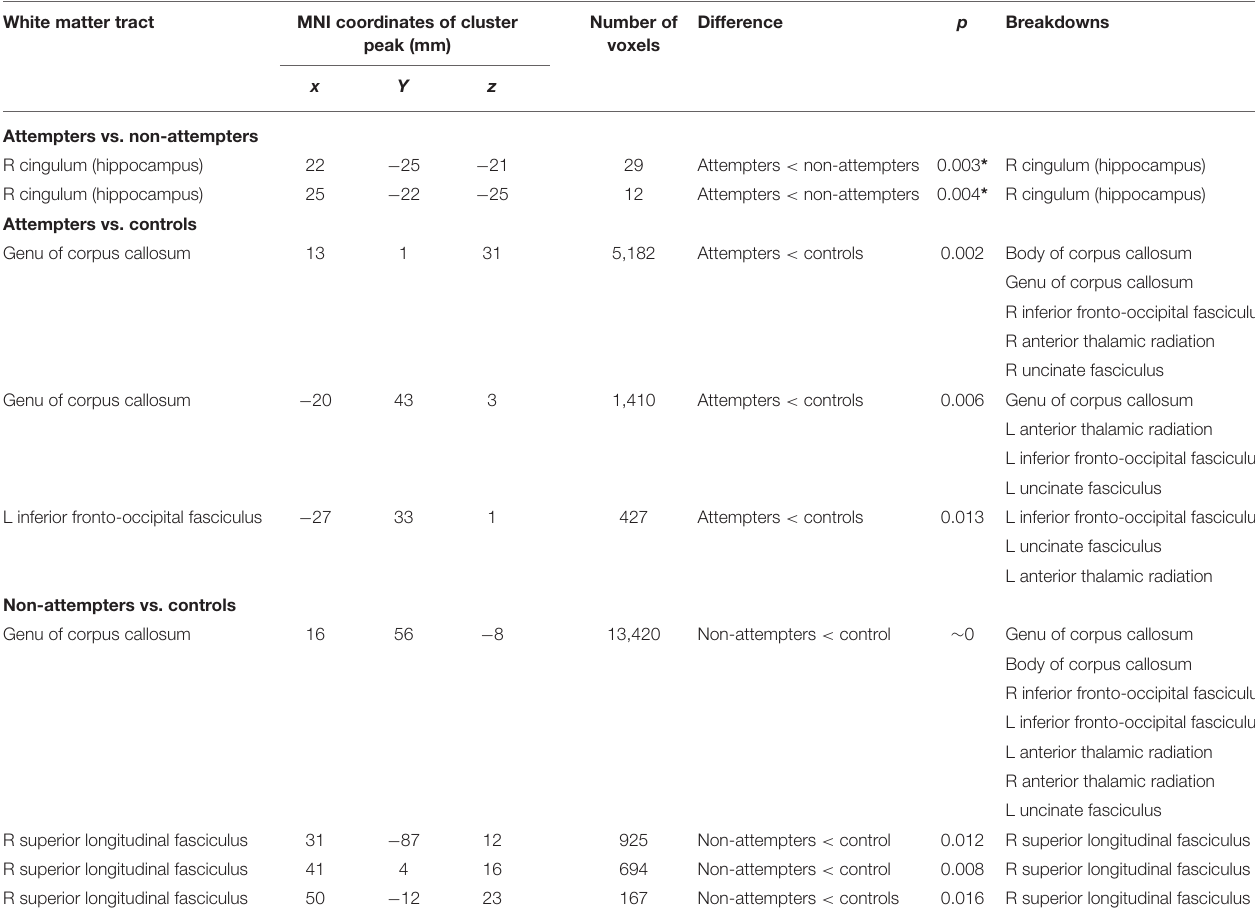
TABLE 2 | TBSS results of attempters, non-attempters, and healthy controls. White matter tract MNI coordinates of cluster peak